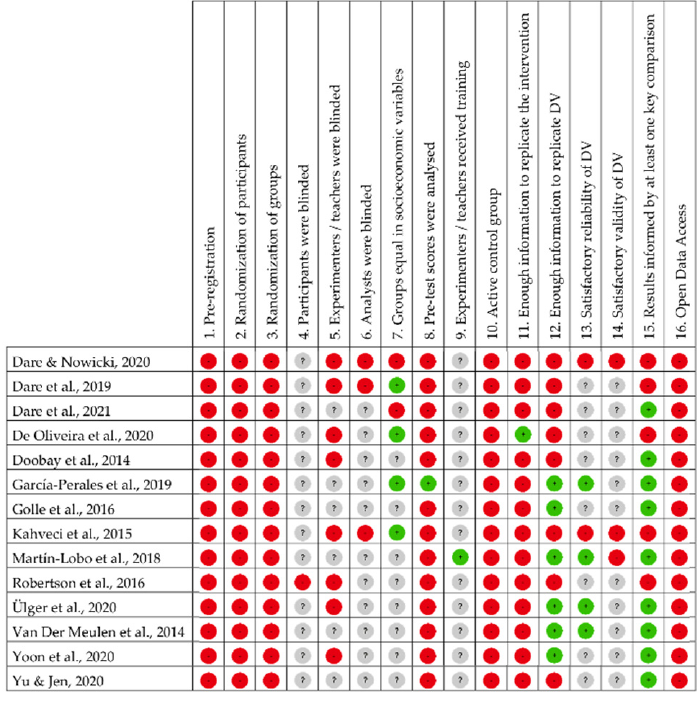
Figure 2. Quality analysis of the articles included.